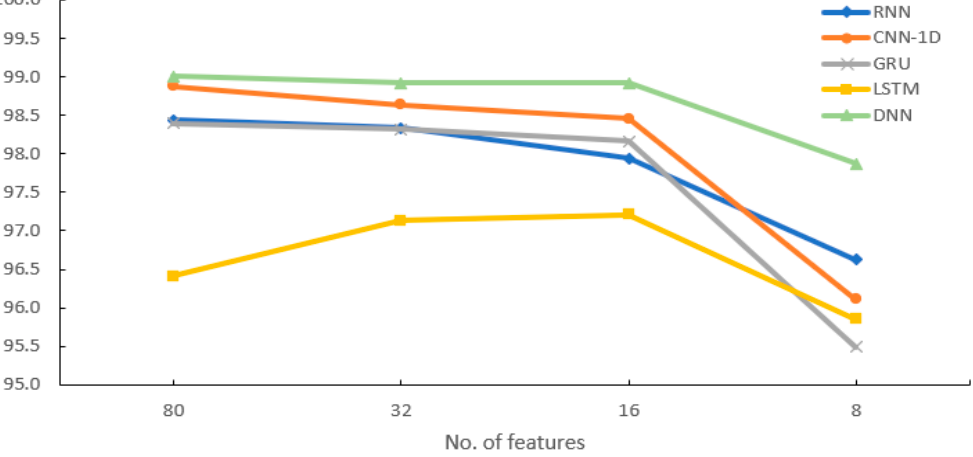
Figure 8. Accuracy [%] of DL-based schemes for the different number of features.